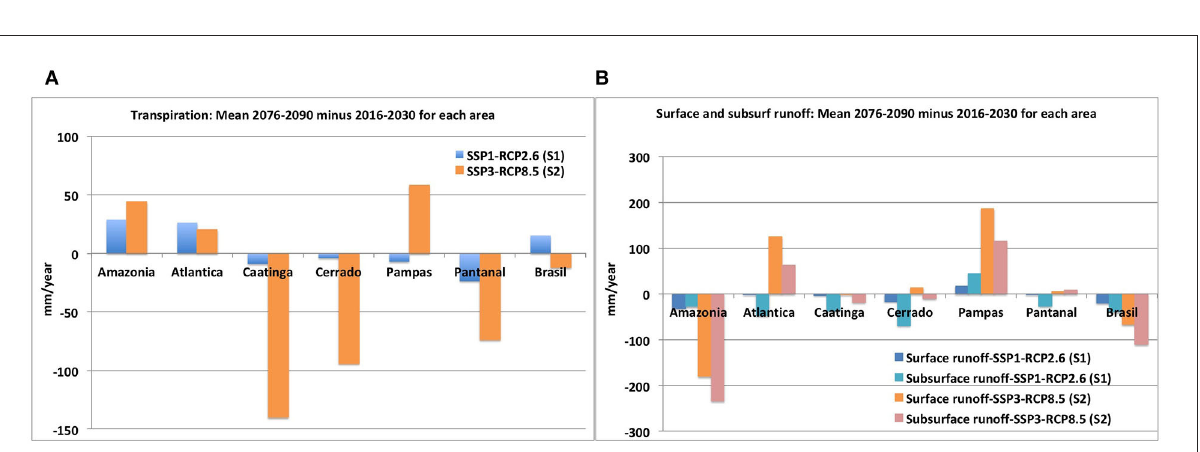
FIGURE4 Difference (mm/year) between the mean of the last and first 15 years of the simulation for each biome for (A) transpiration (S1 in blue and S2 in orange) and (B) surface (S1 in blue and S2 in orange) and subsurface (S1 in green and S2 in pink) runoff.